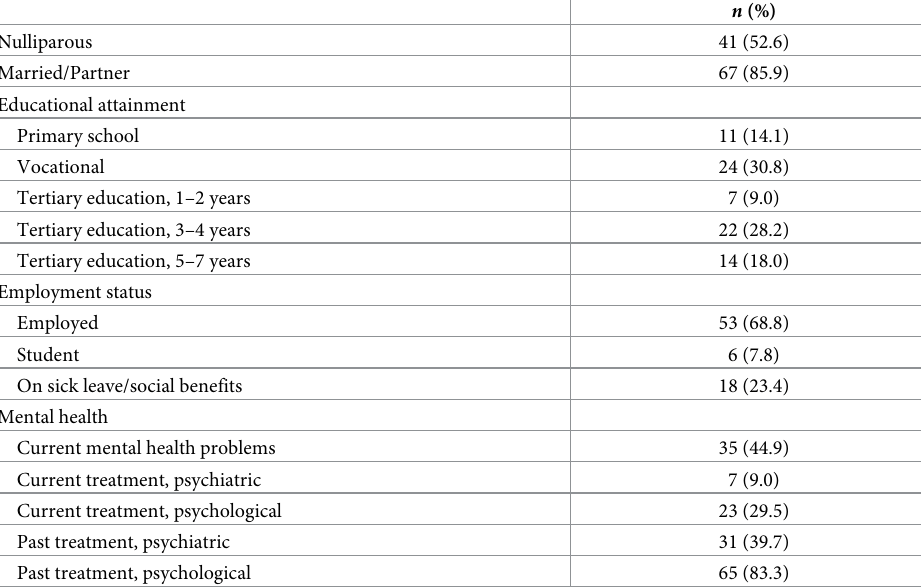
Table 1. Participant characteristics ( N = 78).